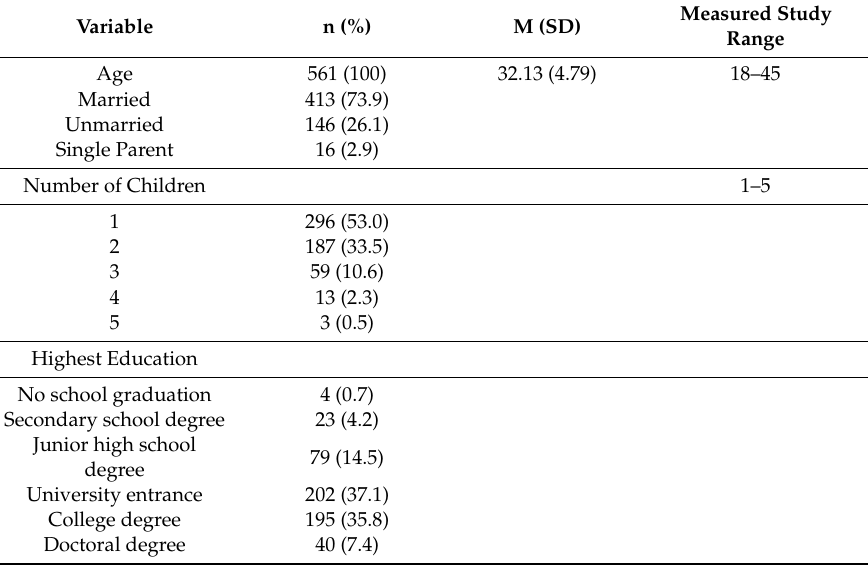
Table A1. Sociodemographic data of the study